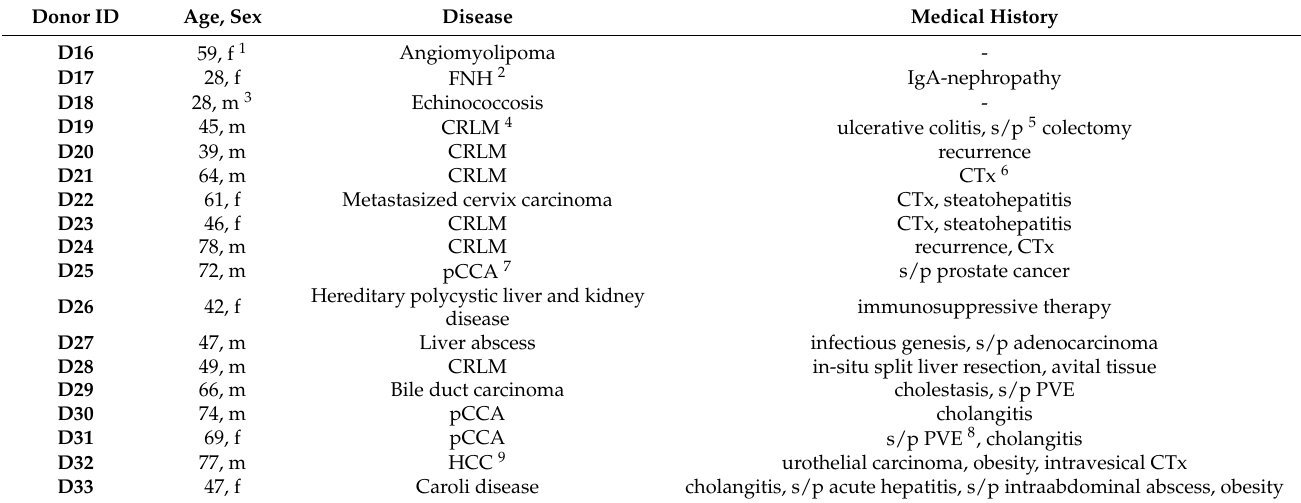
Table 2. Donor data for liver tissue samples used for the isolation of primary human liver cells. Summary of donors including age, sex, as well as medical history.